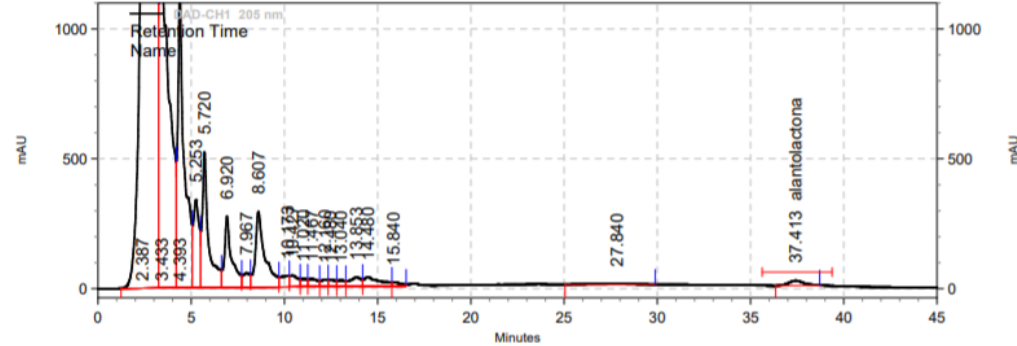
Figure 3. HPLC chromatograms of STOMAPET at 205 nm—alantolactone.